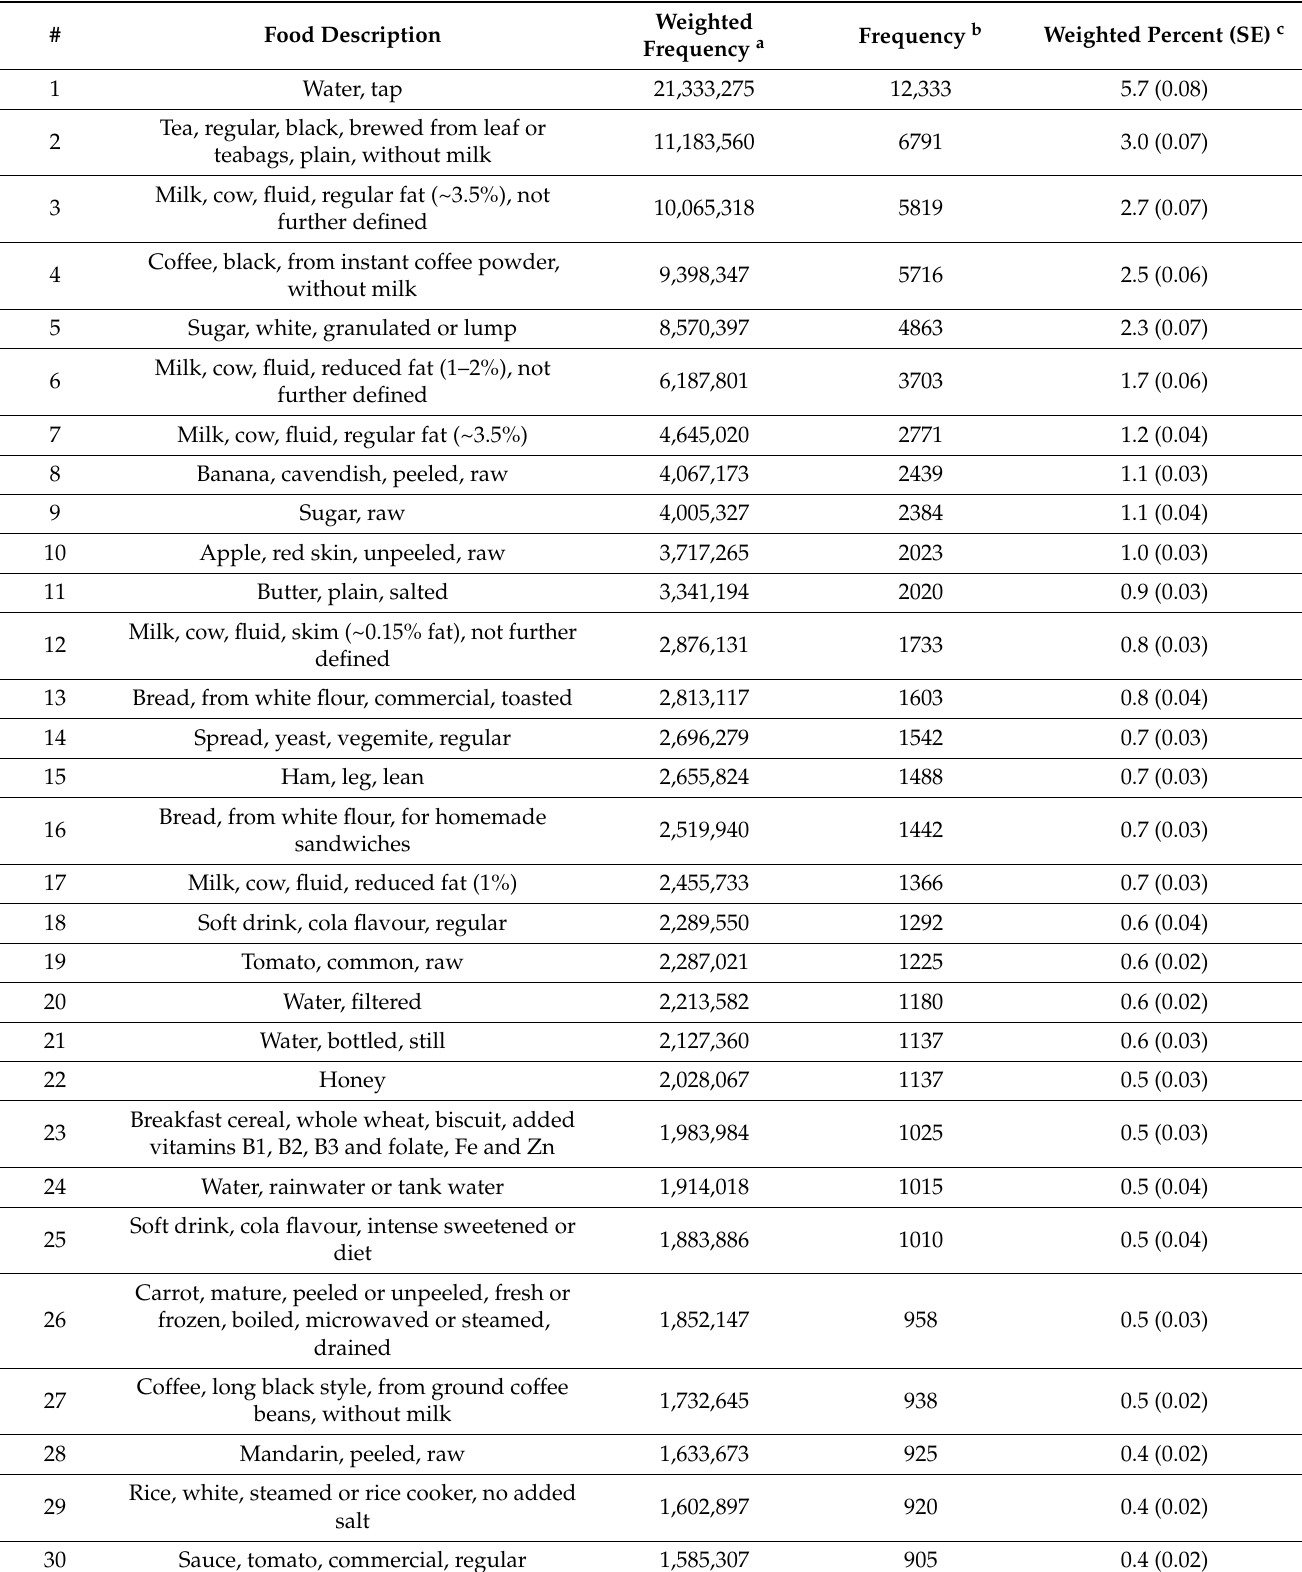
Table 3. The 100 most frequently consumed foods by the Australian